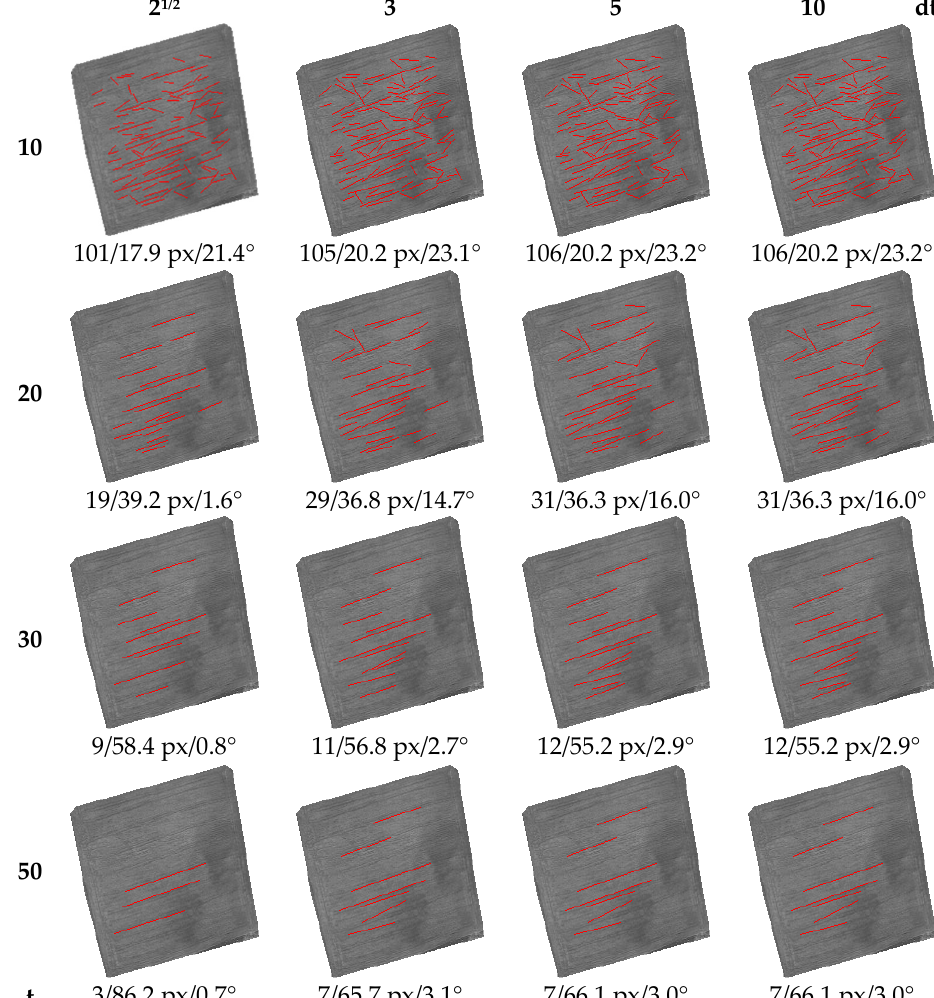
Figure 17. Matrix of combinations showing bivariate relationship between t and dt for Parcel 1323 (spring barley). The numbers below the images represent the number of detected lines/average line length (px)/SD of the orientation of all lines (°) (cth1 = 150, cth2 = 75); lines detected by FLD in red color; data source: [40,41].